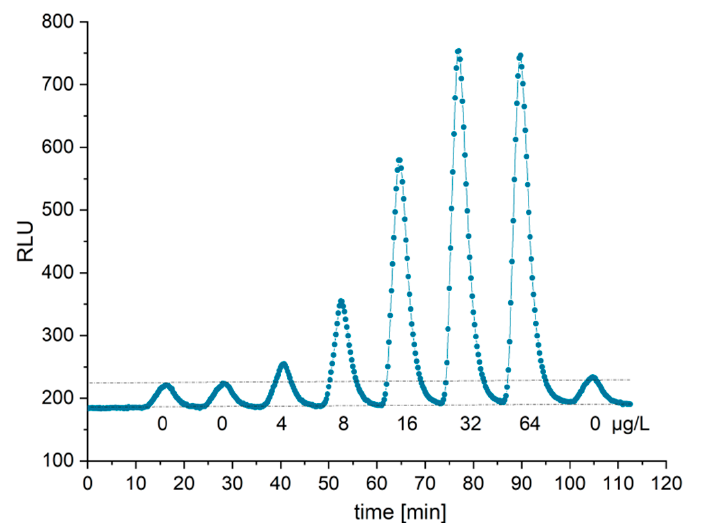
Figure 9. Measurement series of cTnI in a concentration range between 0 and 64 µg/L and estimation of the dynamic range (see Figure S13).